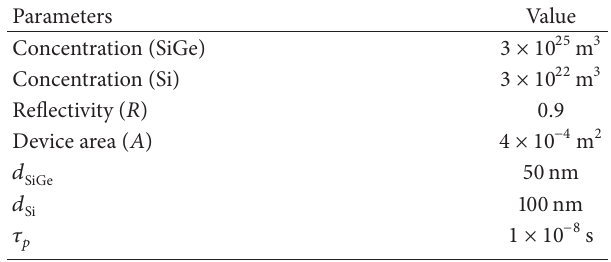
Table 2: Parametric value used in simulation.